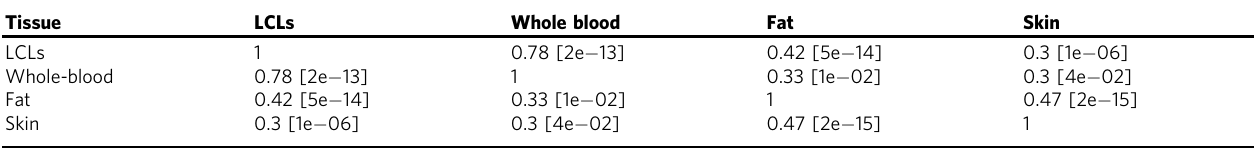
Coef fi cient of correlation [and its p -value] of XCI skew between tissue pairs. n LCLs-Whole_blood = 59; n LCLs-Fat = 288; n LCLs-Skin = 252; n whole_blood-Skin = 47; n whole_blood-Fat = 57; n Fat-Skin =